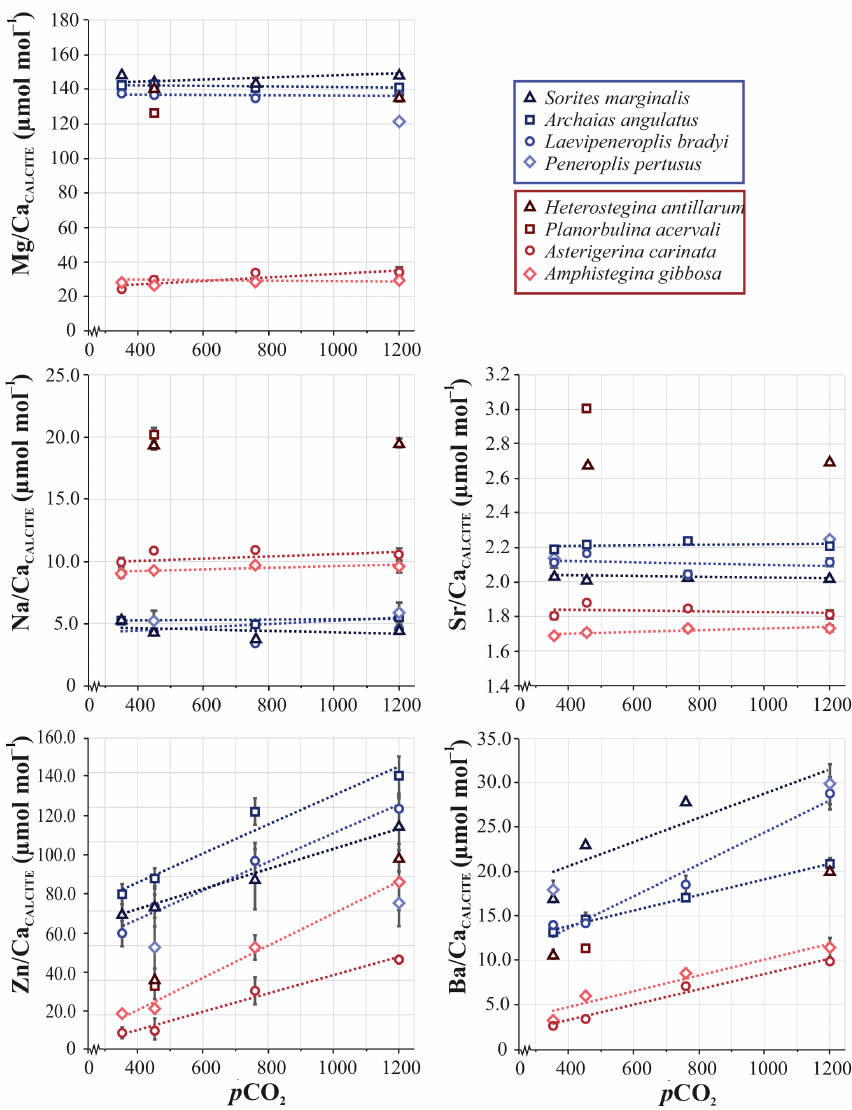
Figure 3. Element to Ca ratios ( ± SE) of different species of foraminifera over a range of p CO 2 values. In some cases, the error bar is smaller than the symbol. Porcelaneous species in blue (triangles, S. marginalis ; squares, A. angulatus ; circles, L. bradyi ; squares, P. pertusus ) and hyaline species in red (triangles, H. antillarum ; squares, P. acervalis ; circles, A. carinata; diamonds, A. gibbosa